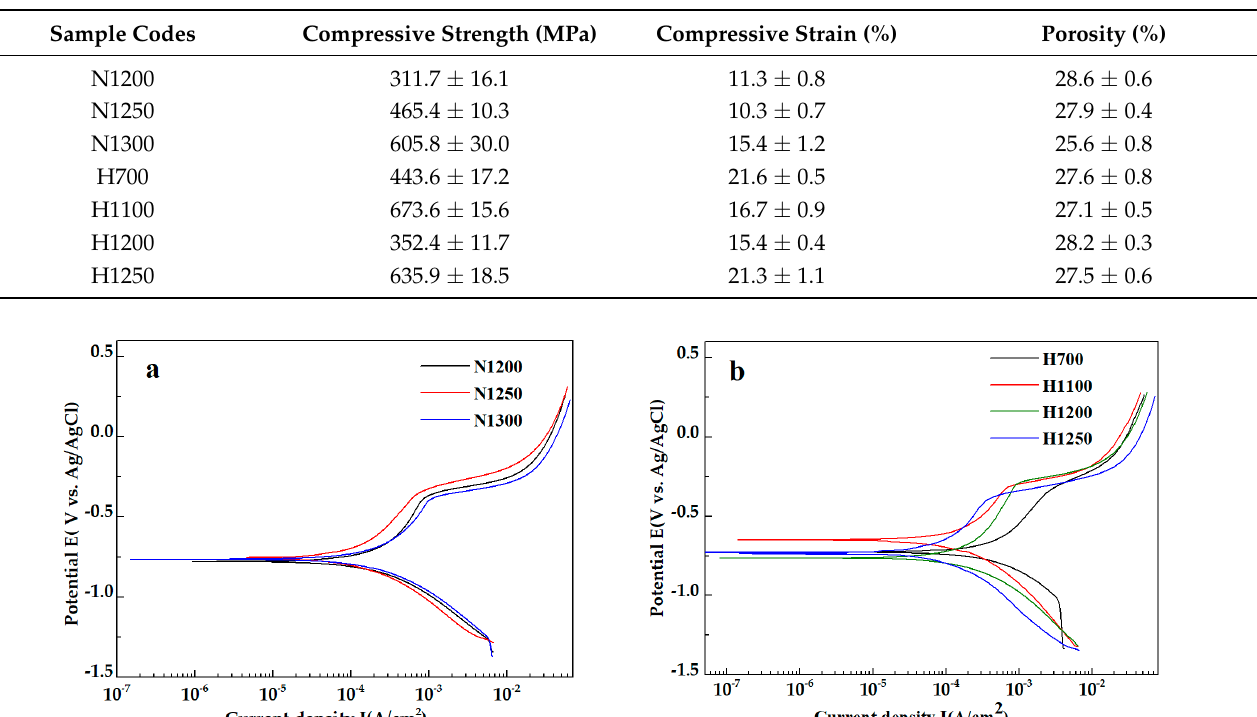
Figure 8. Potentiodynamic polarization curves of the as-fabricated porous samples in 0.9 wt.% NaCl solution. ( a ) unreduced samples N1200, N1250 and N1300, ( b ) reduced samples H700, H1100, H1200 and H1250. Table 8. Corrosion parameters of the as-fabricated porous HNASS samples obtained from the po- tentiodynamic polarization curves.